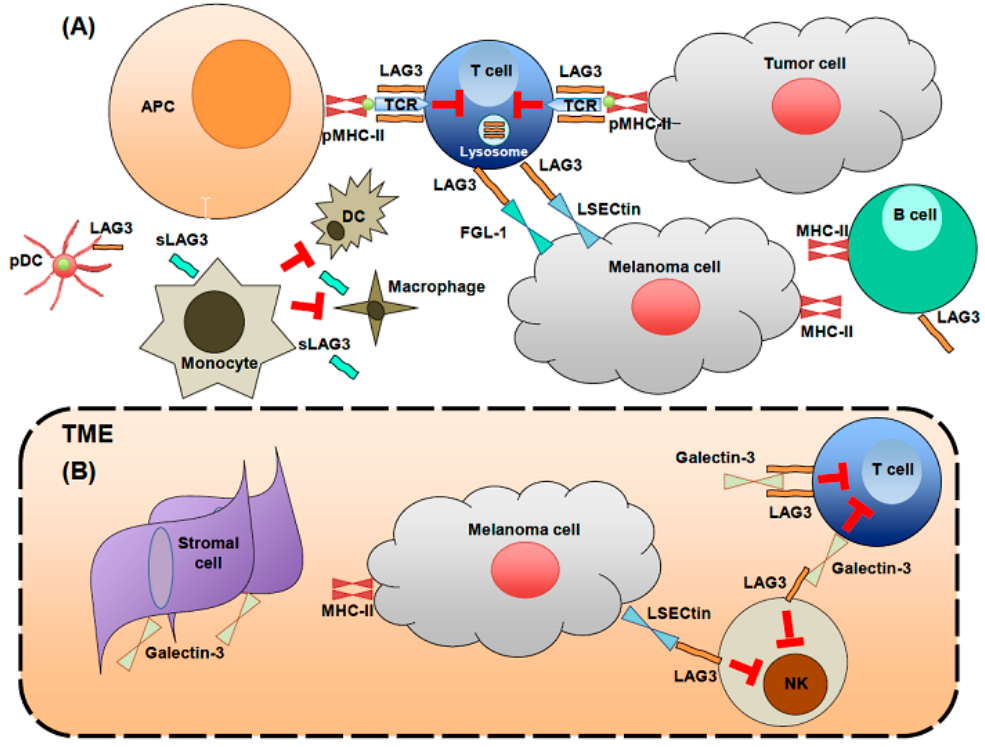
Figure 1. LAG3 biology on immune cells ( A ) and in the tumor microenvironment (TME) ( B ). ( A ). LAG3 is expressed on CD4 + (Th) and CD8 + (CTL) T cells, plasmacytoid dendritic cells (pDC) and NK cells in the TME ( B ). Its principle ligands include: MHC-II expressed on antigen presenting cells (APC) and tumor cells, LSECtin expressed on melanoma cells and galectin-3 expressed on some T cells and stromal cells in the TME ( B ). In its soluble form, LAG3 (sLAG3) impairs monocyte differentiation to dendritic cells (DC) and macrophages. In the TME, interactions mediated by LAG3 and its ligands are inhibitory ( B ).